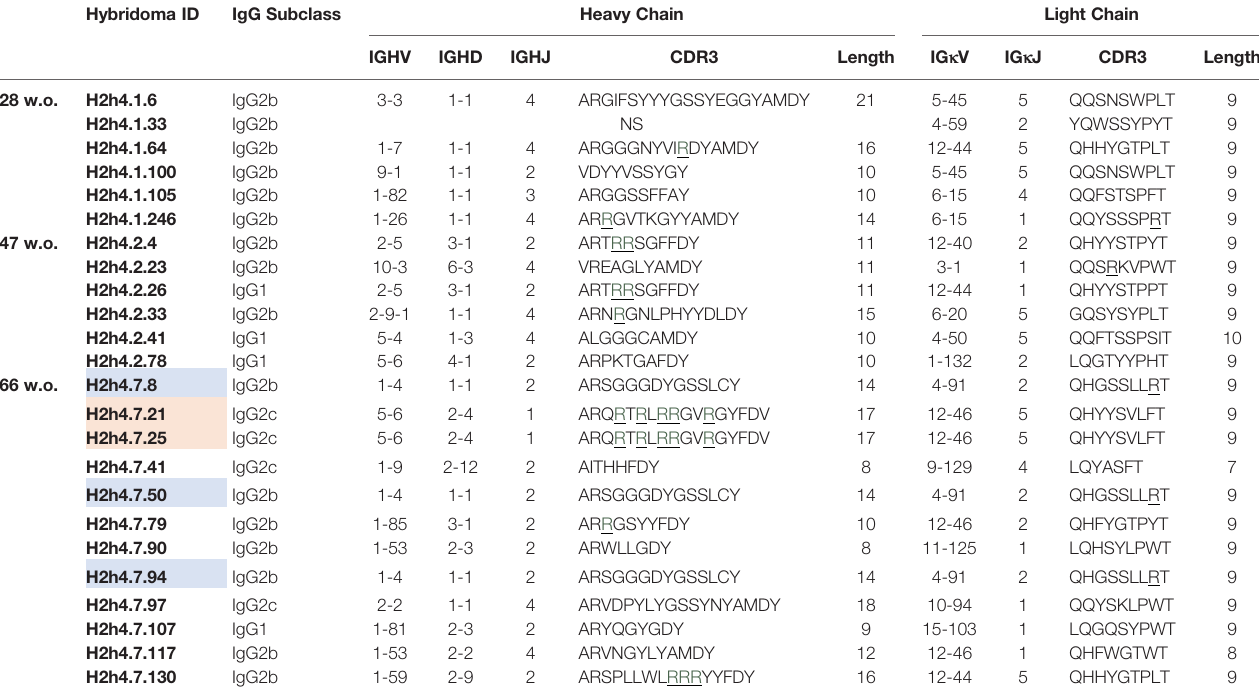
TABLE 2 | IGHV and IGKV of IgG antibodies derived from aging NOD.H-2 h4 mice (28, 47 and 66 w.o). Hybridoma ID IgG Subclass Heavy Chain Light Chain